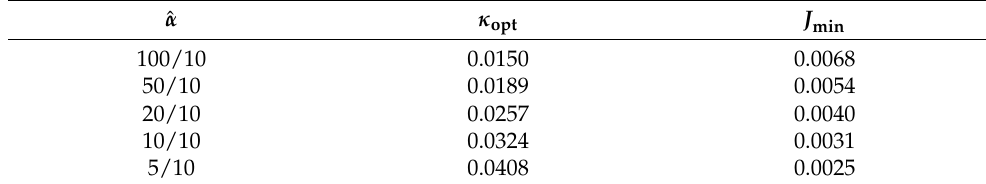
Table 2. Weighting factor/optimal parameter/minimum performance index.